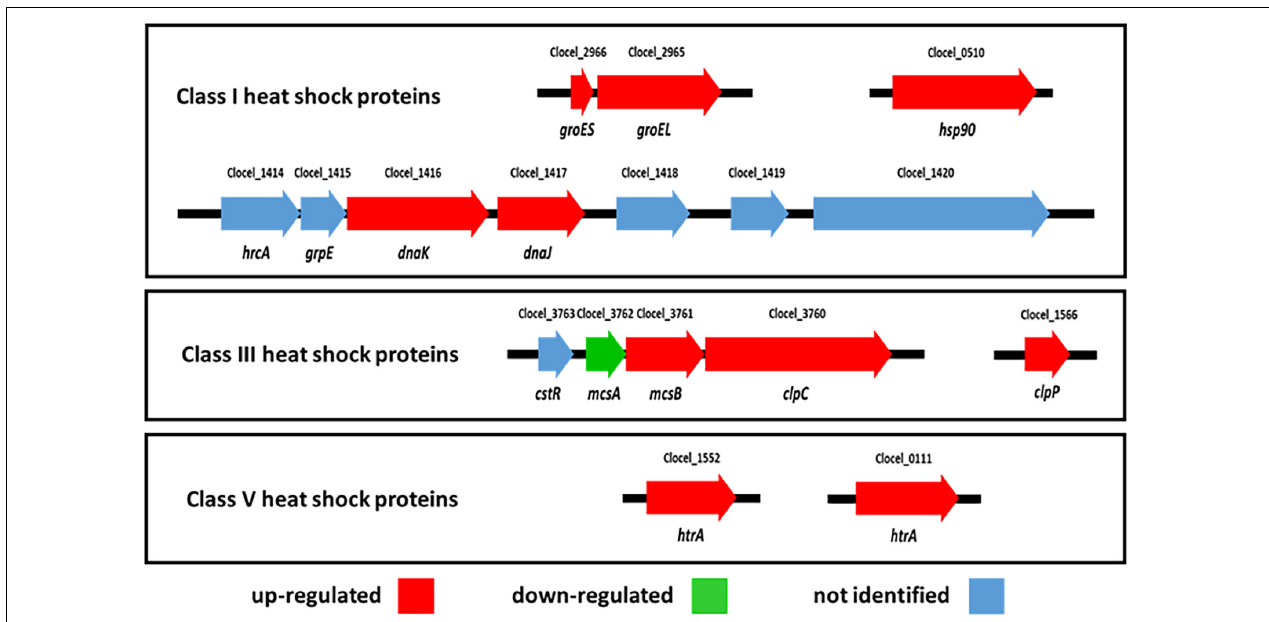
FIGURE 6 | The expression of several heat shock proteins (HSPs) is affected in butanol-challenged C. cellulovorans . The gene loci encoding the main C. cellulovorans HSPs are indicated in red or green depending on if their protein products were up-regulated or down-regulated in butanol challenged cultures. Products of the genes indicated in blue were not identified in the present